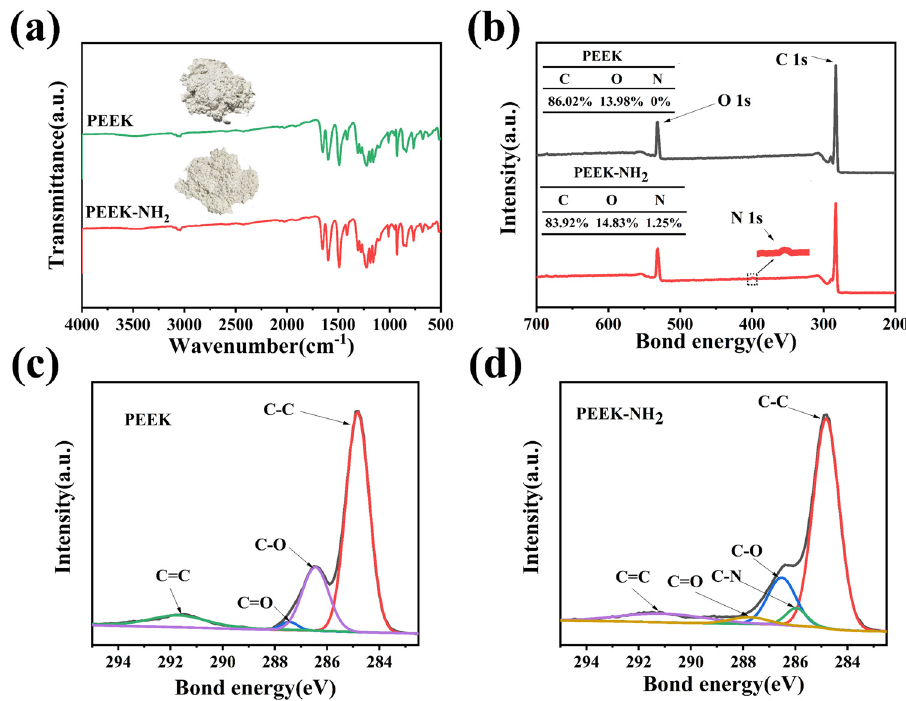
Figure 1: ( a ) FTIR spectra of PEEK and PEEK - NH 2 , ( b ) XPS survey spectrum, ( c ) C 1s peek - fi tting curves of PEEK, and ( d ) PEEK - NH 2 from XPS